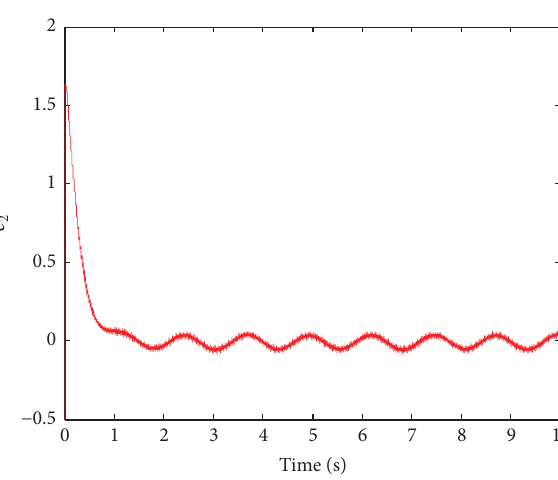
Figure 10: Tracking error 𝑒 2 of input signal